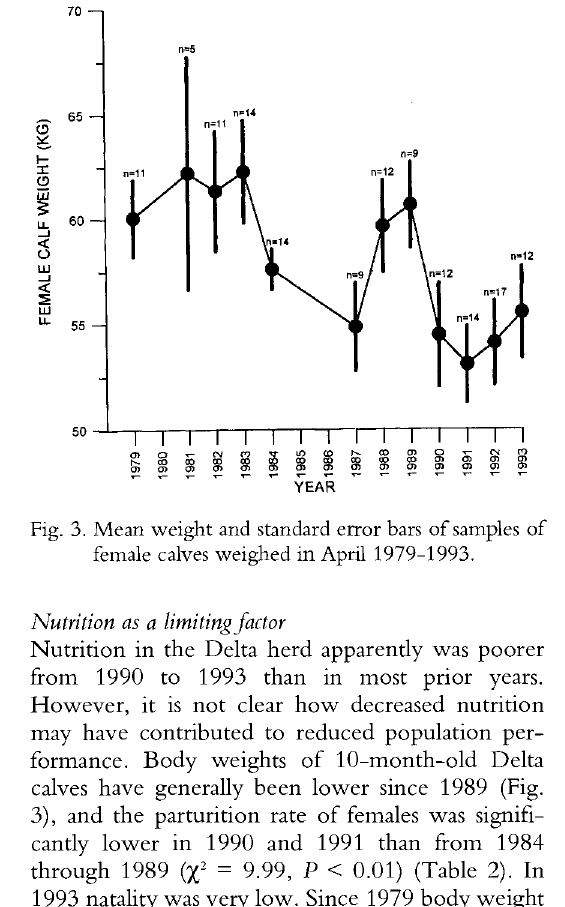
Fig. 3. Mean weight and standard error bars of samples of female calves weighed in April 1979-1993.